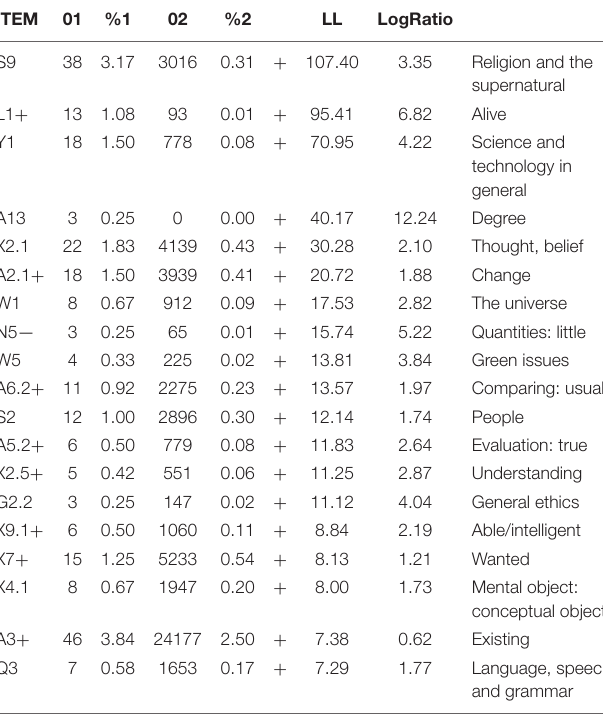
TABLE 6 | Key semantic domains for the text, Can You Believe in God or Revolution